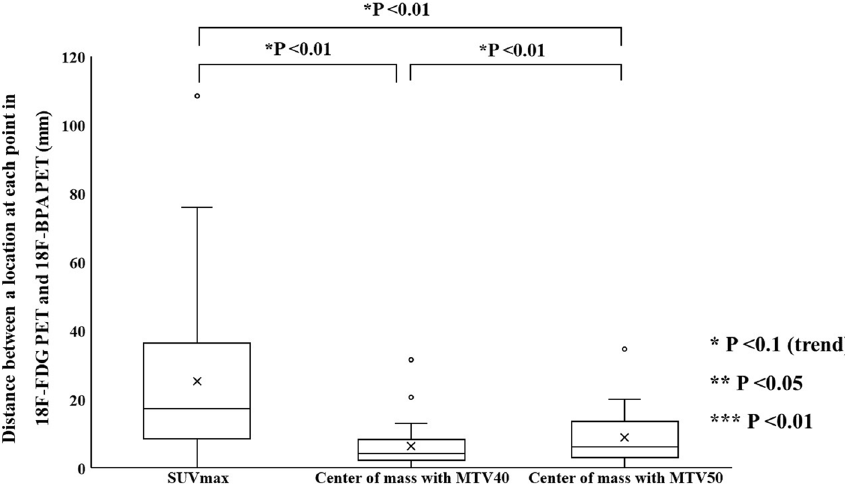
Fig. 10 Comparison of all combinations between each distance (a location at SUV max , the center of mass with MTV40, and MTV50), obtained from 18 F-FDG and 18 F-BPA PET for all